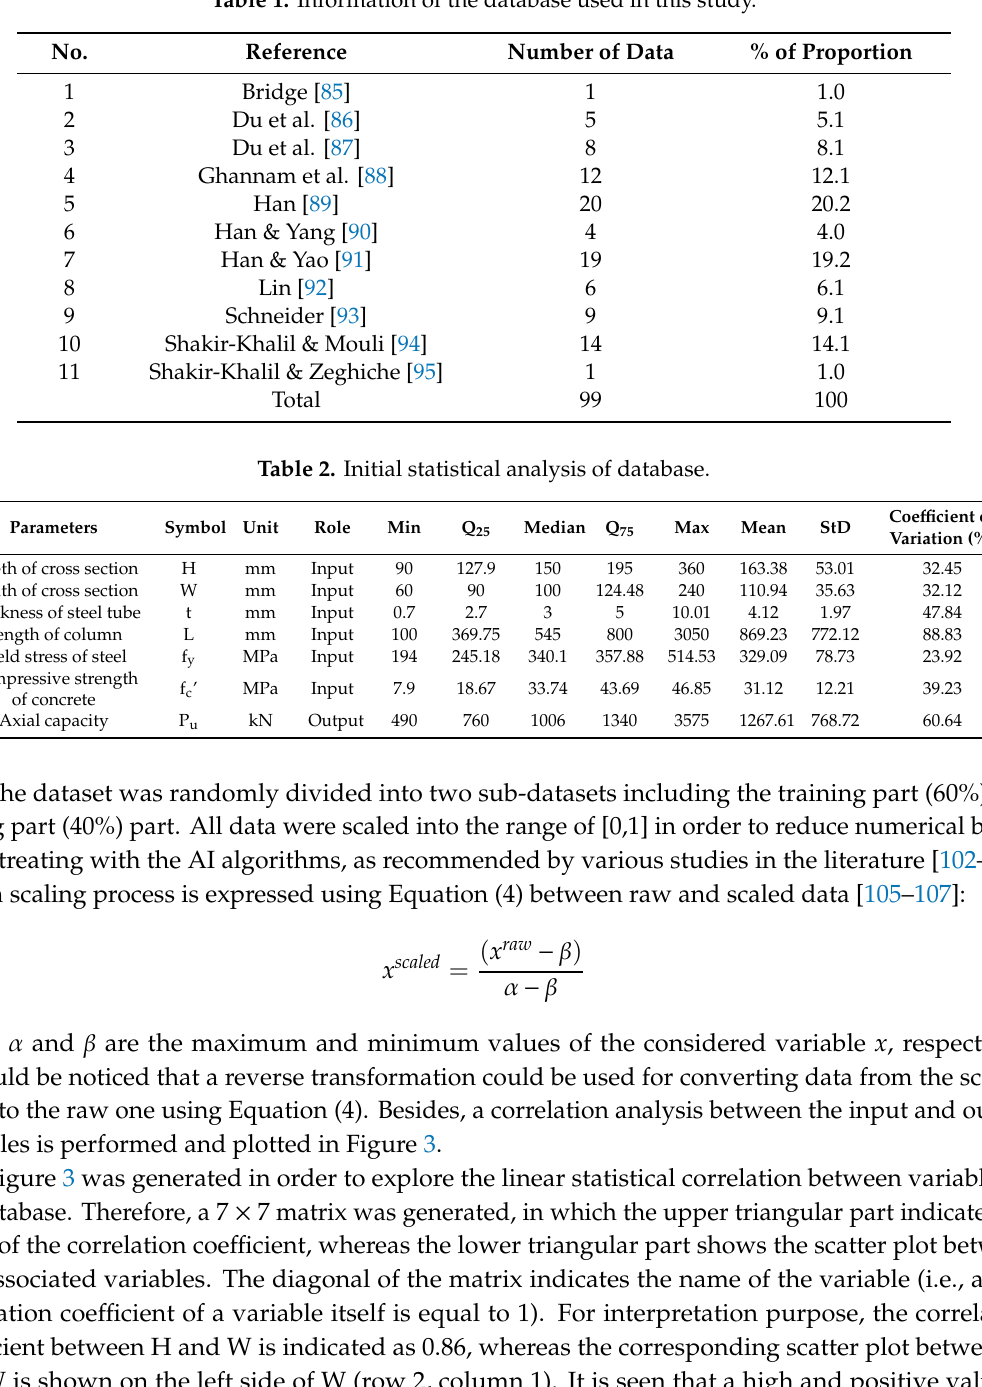
Table 1. Information of the database used in this study.